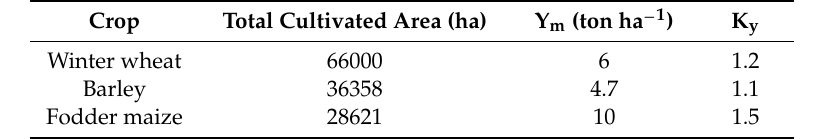
Table 4. Total cultivation area, maximum yield (Y m ), and the coe ffi cient of the reaction of crop yield to water stress (K y ) for winter wheat, barley, and fodder maize in the Qazvin Plateau (Najarchi et al., 2011). Crop Total Cultivated Area (ha) K y 66000